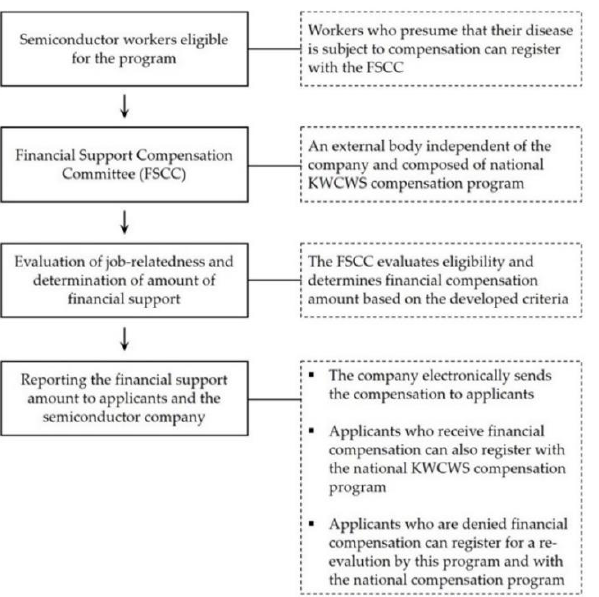
Figure 1. Procedures for the financial support compensation (FSC) programs for semiconductor workers with suspected work-related diseases (WRDs) operated by two semiconductor companies.